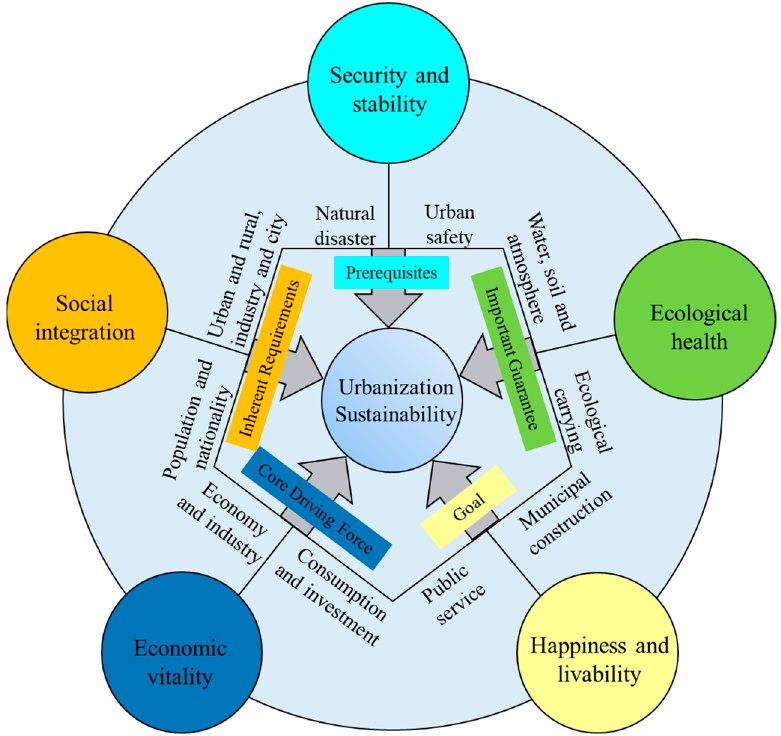
Figure 2. Theoretical connotation of urbanization sustainability of Xinjiang.